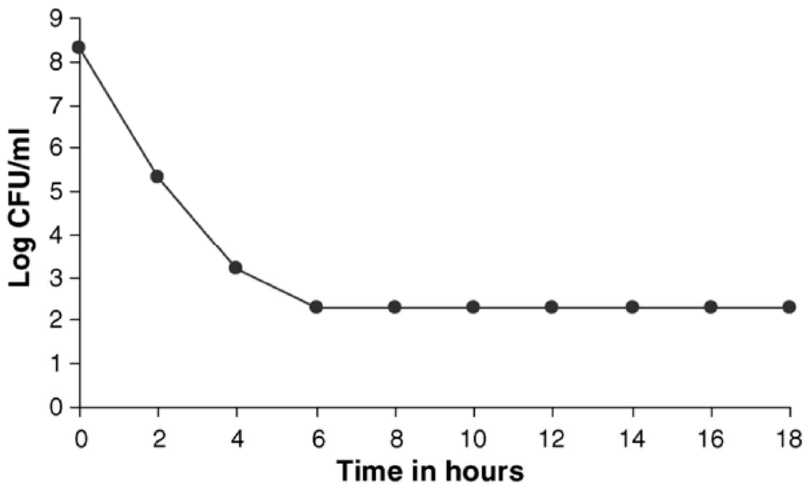
Figure 1. Bacteriostatic action of 20 µg/mL flupenthixol on Staphylococcus aureus NCTC 6571 (minimum inhibitory concentration of 10 µg/mL). Adapted from: Jeyaseeli et al. 2006 [53].